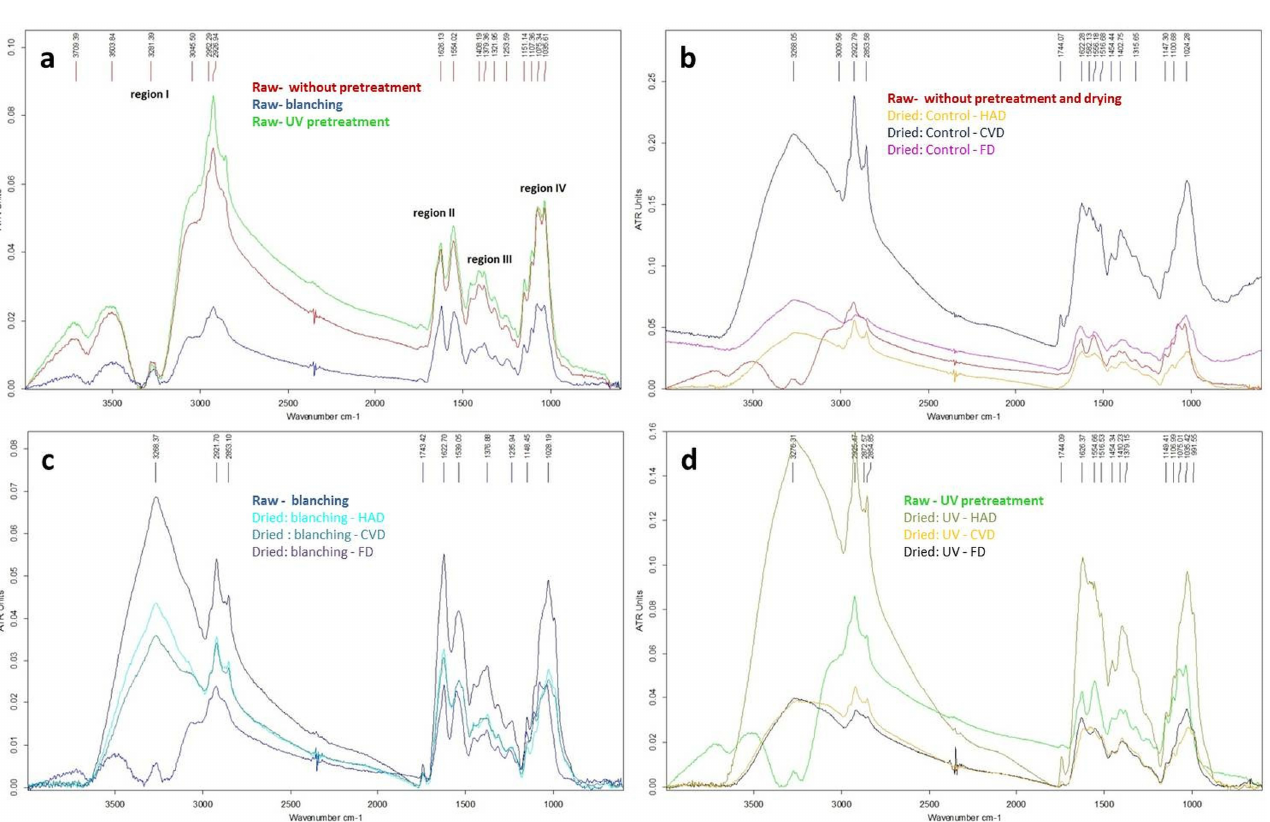
Figure 6. ATR-FTIR spectra of B. edulis mushrooms, subjected to different pretreatment and drying methods; ( a ) raw without/with pretreatment, ( b ) raw without pretreatment and drying/dried without pretreatment, ( c ) blanched raw/blanched dried, ( d ) UV-pretreated raw/UV-pretreated dried.